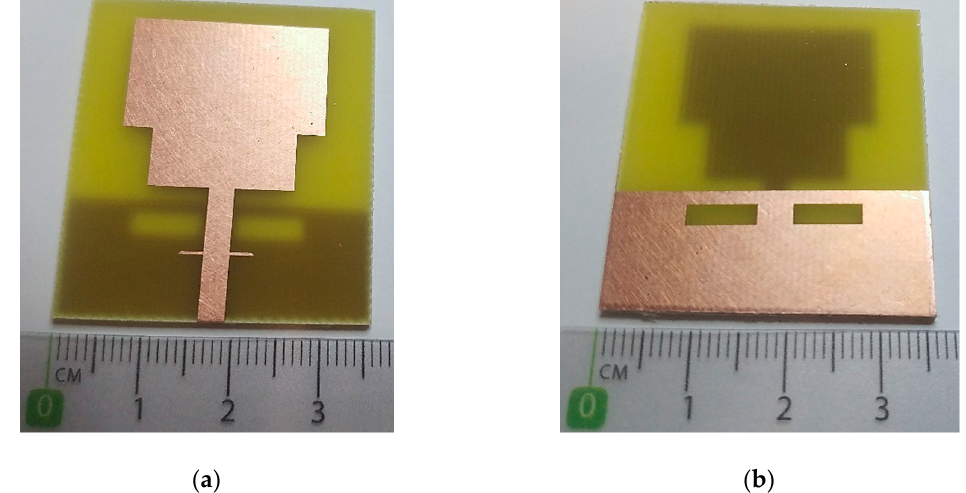
Figure 9. Photograph of the manufactured antenna: ( a ) Top layer; ( b ) Bottom layer.